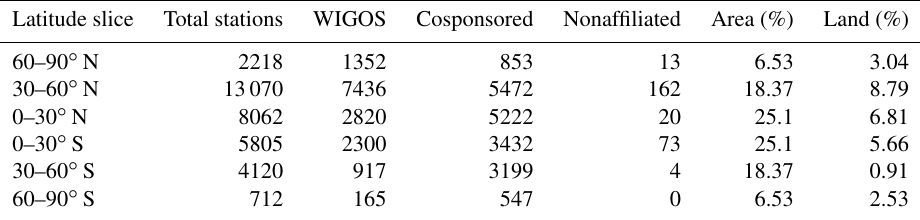
Table 2. WMO OSCAR statistics on operational stations in 30 ◦ latitude slices; iCUPE stations are mostly nonaffiliated. Latitude